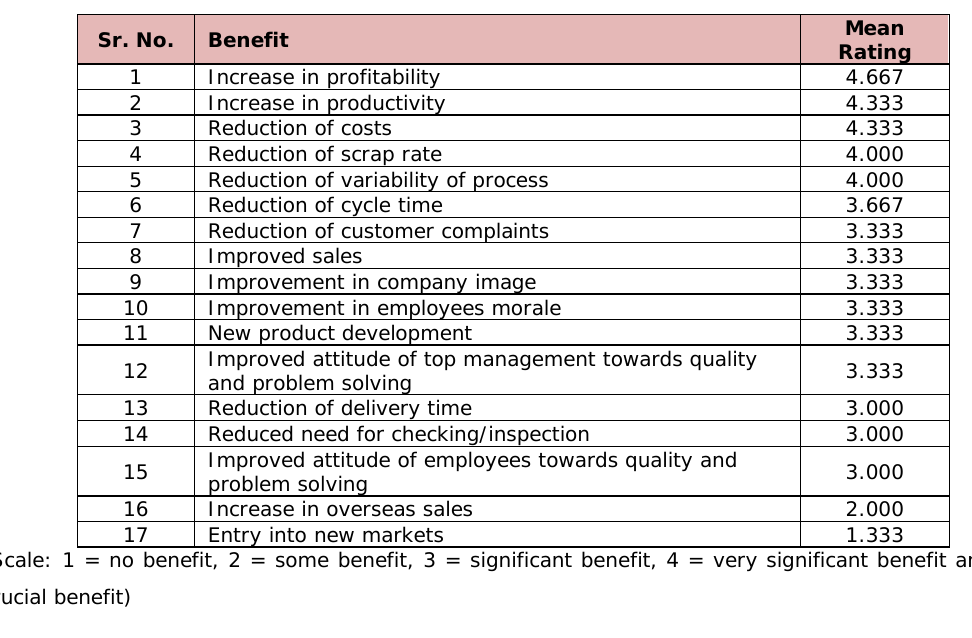
Table 3. “Benefits gained due to Six Sigma implementation by medium scale industries (Mean ratings arranged in descending order of